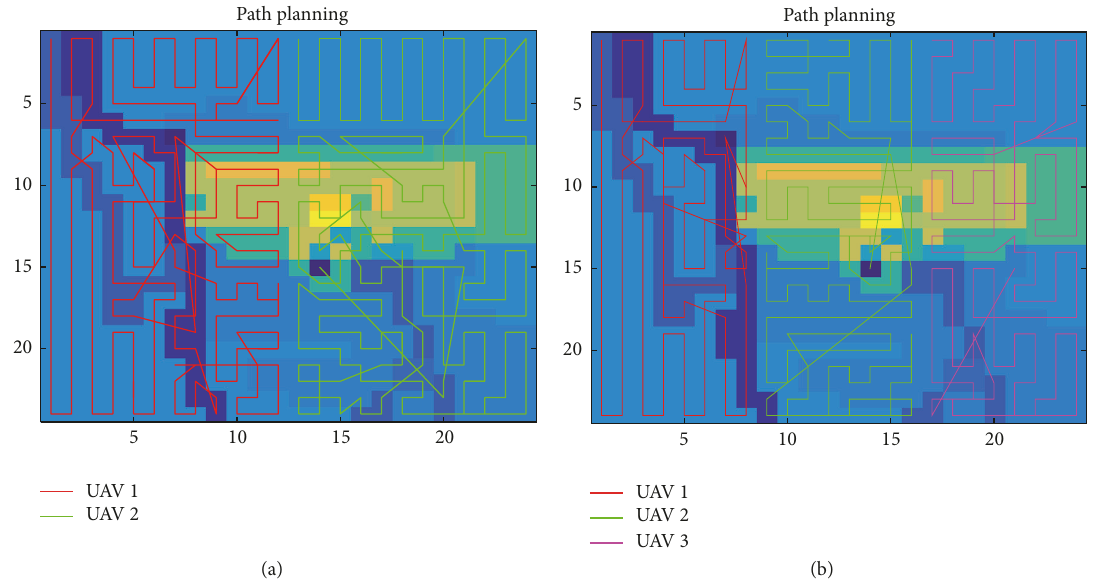
Figure 13: La Palma attraction path planning with 2 UAVs (a) and 3 UAVs (b), distributed formation.